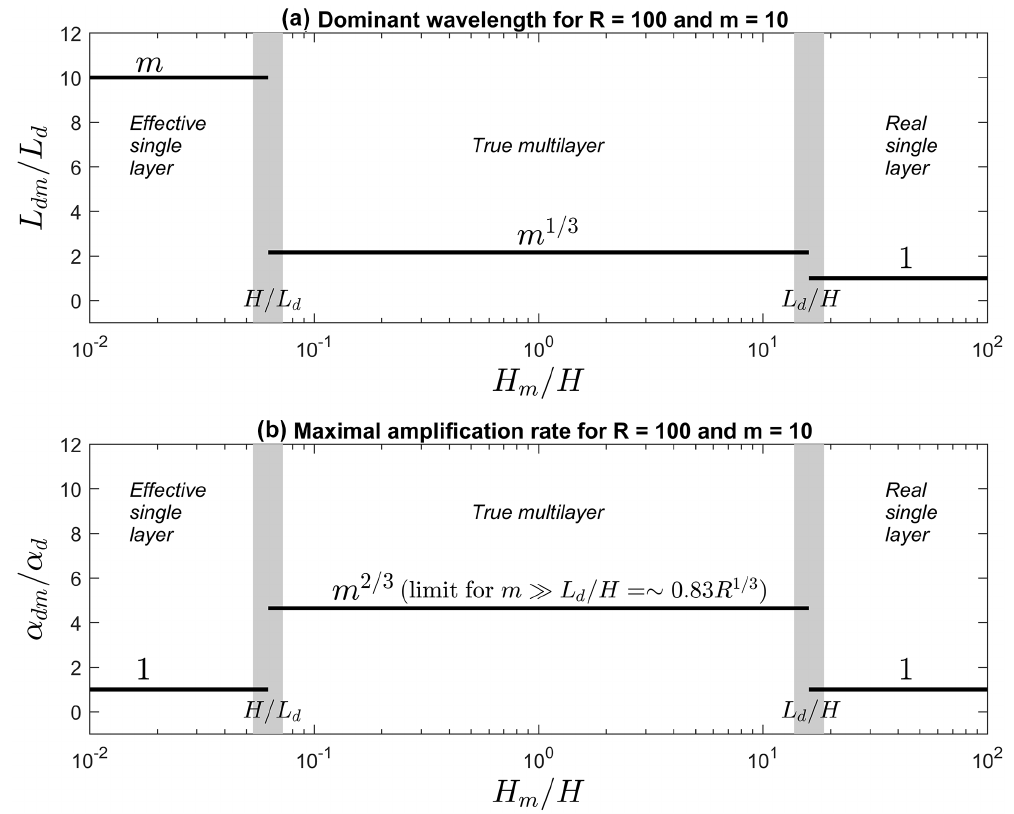
Figure 20. Impact of spacing of competent layers ( H m ) in an embedded multilayer with constant spacing and layer thickness ( H) on the dominant wavelength of the multilayer ( L dm ) in (a) and maximal amplification rate ( α dm ) in (b) , using the approximate solutions of Schmid and Podladchikov (2006; see also text). The results are non-dimensionalised by the dominant wavelength for corresponding single layer folding ( L d of Eq. 13) and the corresponding maximal amplification rate ( α d of Eq. 14). Results are shown for a viscosity ratio between competent and weak layers R = 100 and 10 competent layers ( m = 10). The transition zone between the three folding modes (effective single layer, true multilayer or real single layer; see text) is controlled by H/L d and L d /H (indicated by vertical grey bars). L dm is always larger than L d when H m < ∼ L d and the factor by which L dm is larger than L d depends only on m . In the real single layer mode L dm = L d because H m > ∼ L d and individual layers in the multilayer can fold independent of each other (concept of contact strain; see text). Values of α dm =∼ α d for close spacing (effective single layer; H m /H < ∼ H/L d ) and wide spacing (real single layer; H m > ∼ L d ) . For intermediate spacing (true multilayer) α dm =∼ m 2 / 3 α d . There is an upper limit for many layers ( m (cid:29) L d /H) given by α dm =∼ 0 . 83 R 1 / 3 α d . The impact of multilayers on dominant wavelength and amplification rate can be seen in the numerical simulation displayed in Fig.